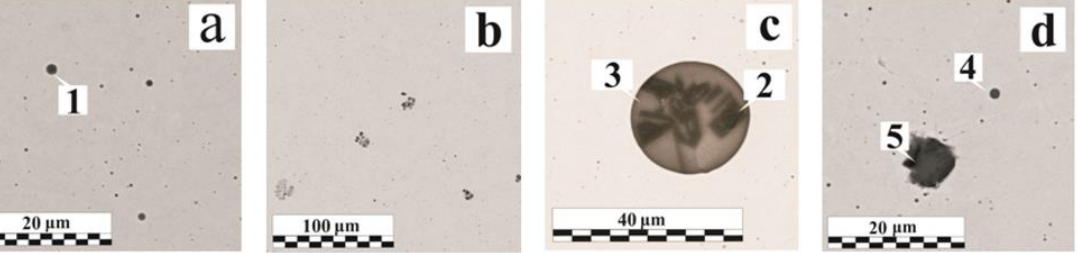
Figure 4. Nonmetallic inclusions in welds: ( a ) without coating; ( b ) with OS-51-03 green, 95 μm; ( c , d ) with OS-51-03 green, 115 μm.